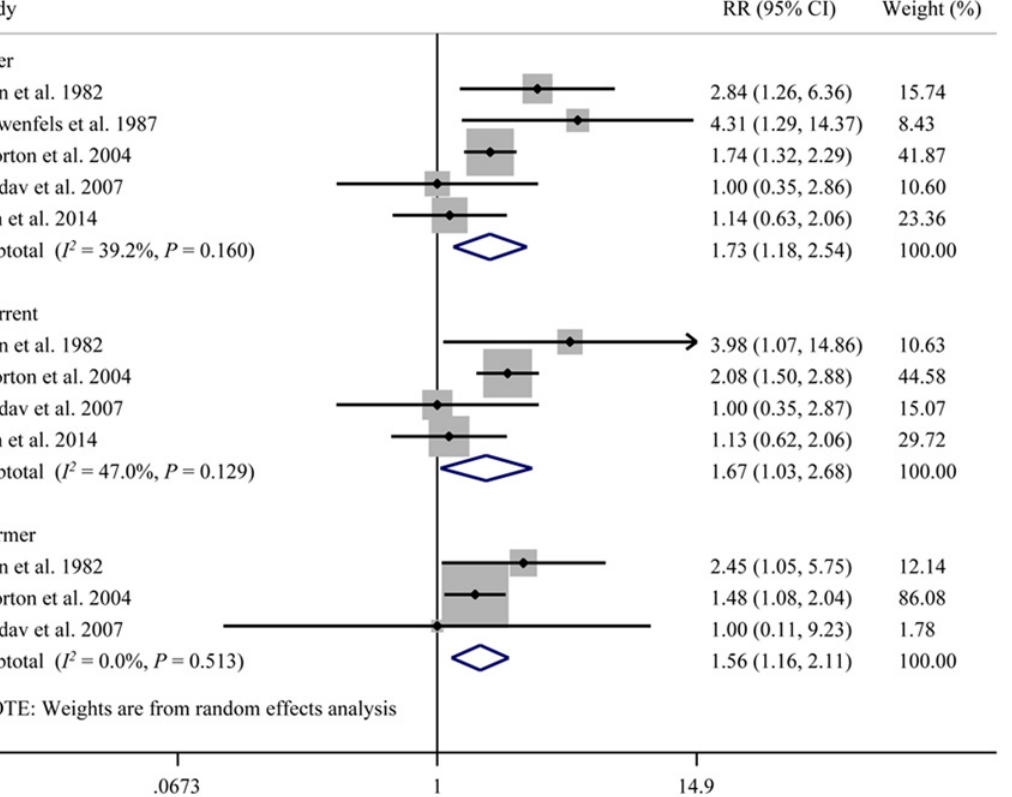
Fig 4. Cigarette smoking and the risk of pancreatitis (acute and chronic combined into one single outcome). CI, confidence interval; RR, relative risk.